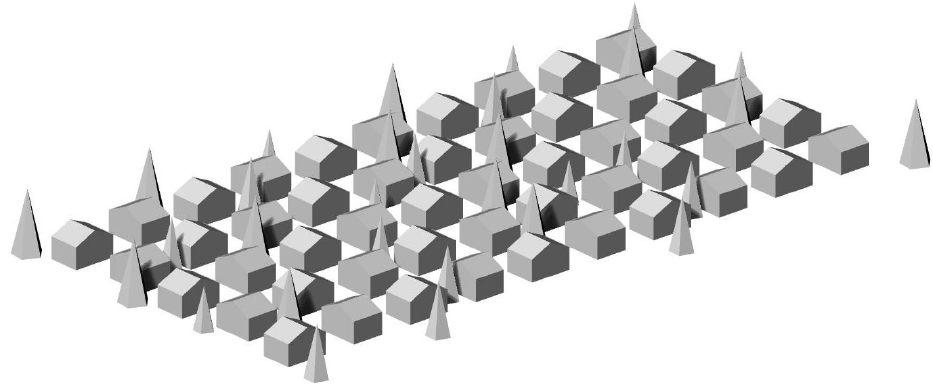
Figure 2. Case study used for the simulation of different scenario of the residential